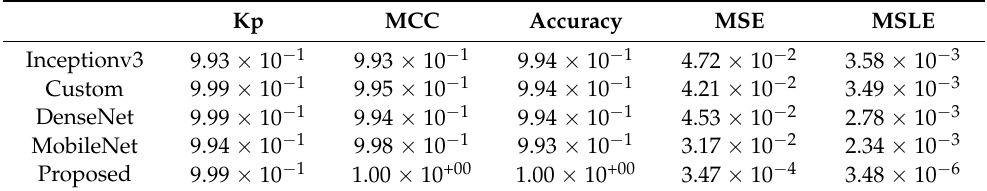
Table 2. The classification report for each of the models and the final model using the NEU dataset. Kp